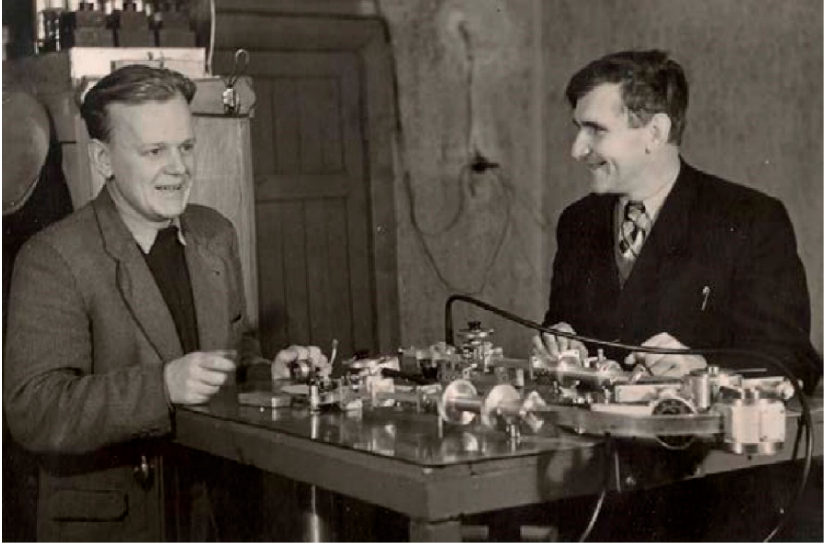
Figure 1. Mikhail A. Eliashevich (right) with his disciple Stanislav S. Shushkevich (left) near the microwave assembly of their handmade EPR spectrometer. Minsk, 1957. Source: personal archive of V.N. Linev.